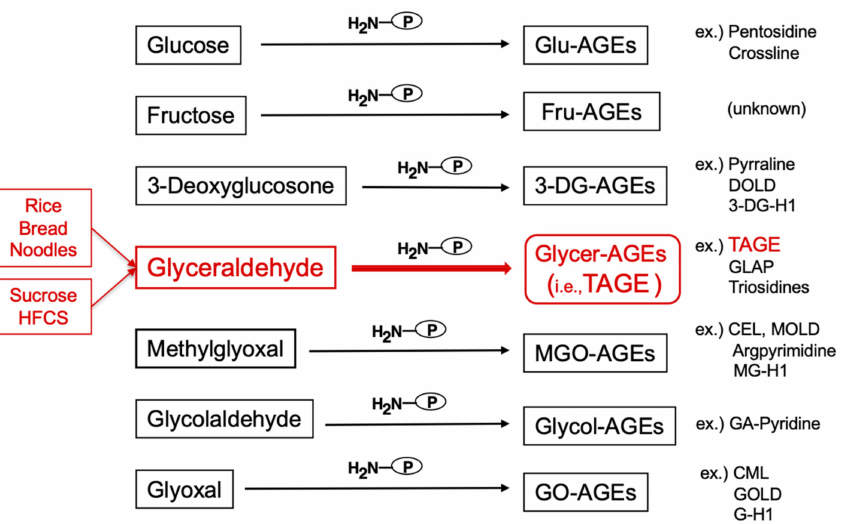
Figure 1. Various routes for the in vivo production of advanced glycation end-products (AGEs). Reducing sugars, including glucose, fructose, and glyceraldehyde, react non-enzymatically with the amino/guanidino groups of proteins, resulting in the formation of reversible Schiff bases and Amadori products/Heyns products. Further complex reactions involving these early glycation products, such as rearrangement, dehydration, and condensation reactions, lead to irreversibly cross-linked, heterogeneous fluorescent derivatives, named AGEs. Glu-AGEs: glucose-derived AGEs; Fru-AGEs: fructose-derived AGEs; 3-DG-AGEs: 3-deoxyglucosone-derived AGEs; Glycer- AGEs: glyceraldehyde-derived AGEs; TAGE: toxic AGEs; MGO-AGEs: methylglyoxal-derived AGEs; Glycol-AGEs: glycolaldehyde-derived AGEs; GO-AGEs: glyoxal-derived AGEs;